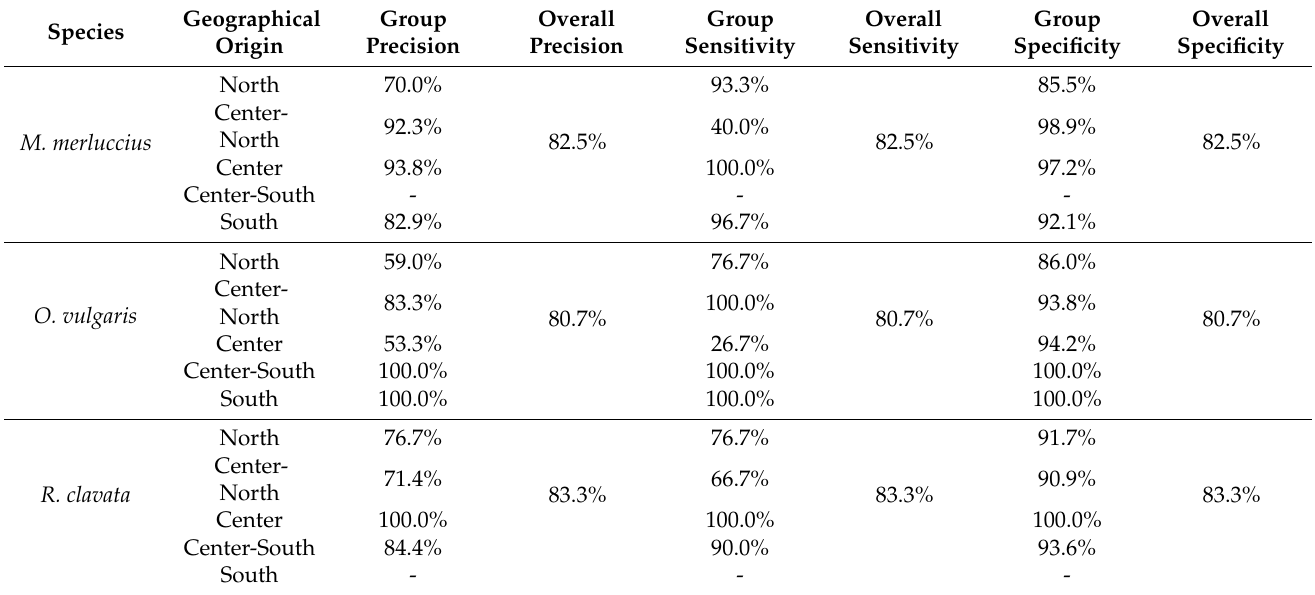
Figure 6. Partial least-squares discriminant analysis (PLS-DA) cross-validation classification accuracy heatmaps per sampling area and for all the different species considered ( Merluccius merluccius , Octopus vulgaris , Raja clavata , Sparus aurata, and Scomber colias ). Table 1. Partial least-squares discriminant analysis (PLS-DA) model cross-validation performance (precision, sensitivity, and specificity) per geographical origin area and overall, based on the pro- cessed (Savitzky–Golay first-order differentiation filter) X-ray fluorescence reflectance spectra of the along the Portuguese